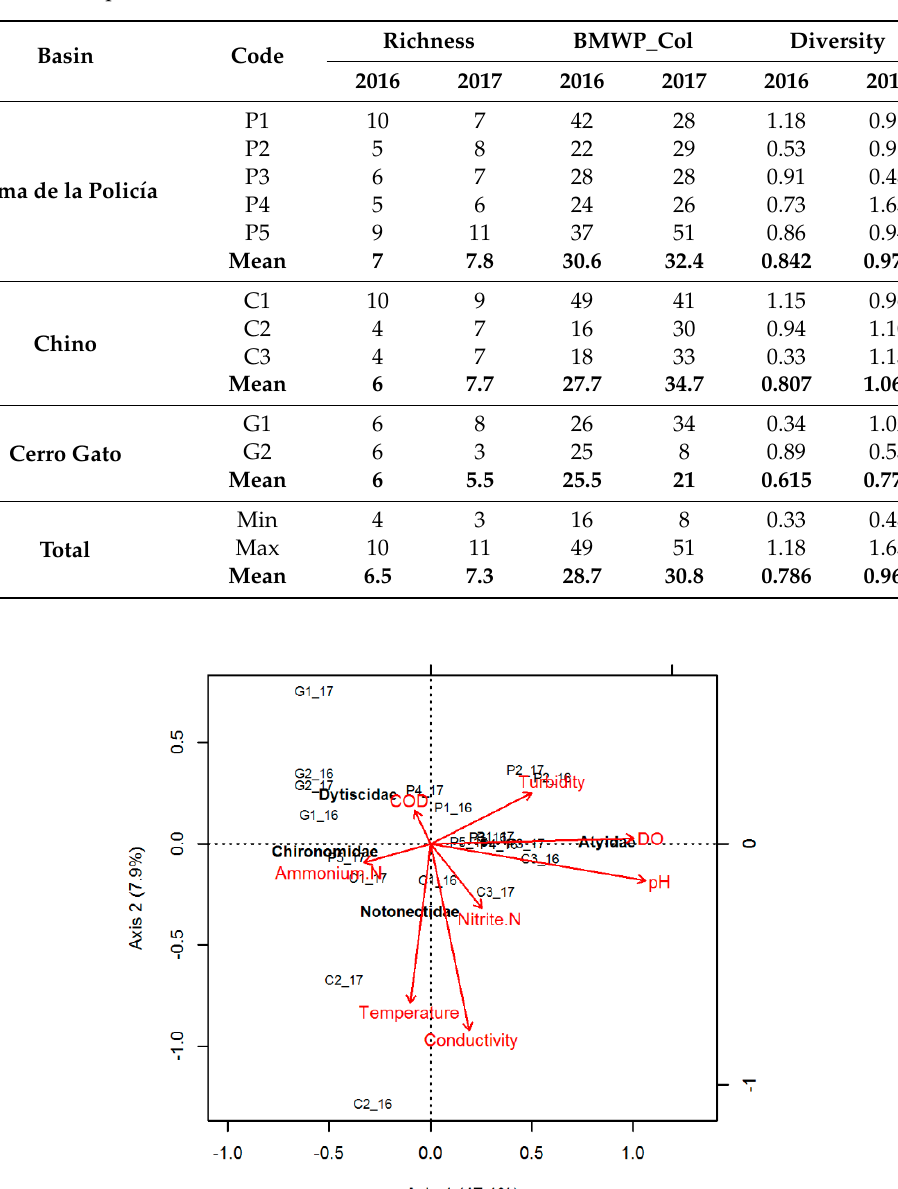
Table 2. Summarizing metrics of macroinvertebrate community within streams on San Crist ó bal island (Galapagos). Metrics include richness (number of taxa), the BMWP_Col score (taxa-based tolerance score), and diversity (combining richness and abundance). The observed range (Min–Max) and arithmetic mean (mean) for each metric–year combination as well as the mean metric value for each basin are reported.